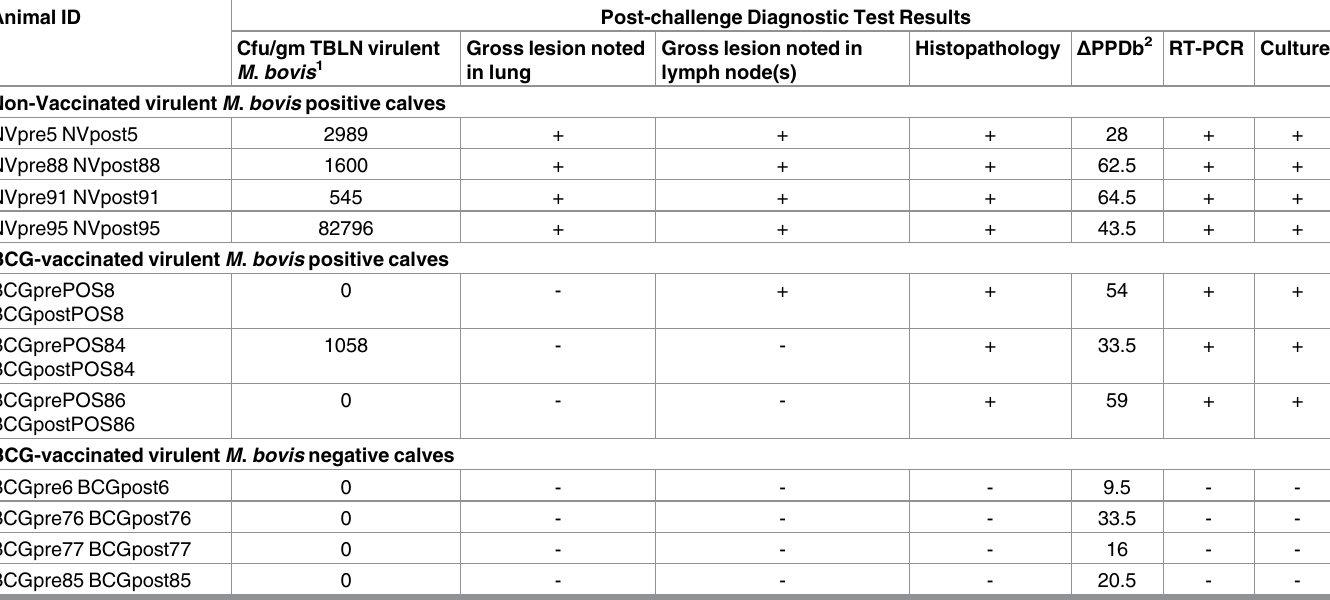
Table 1. Sample group designation and diagnostic test results for calves. Animal ID Post-challenge Diagnostic Test